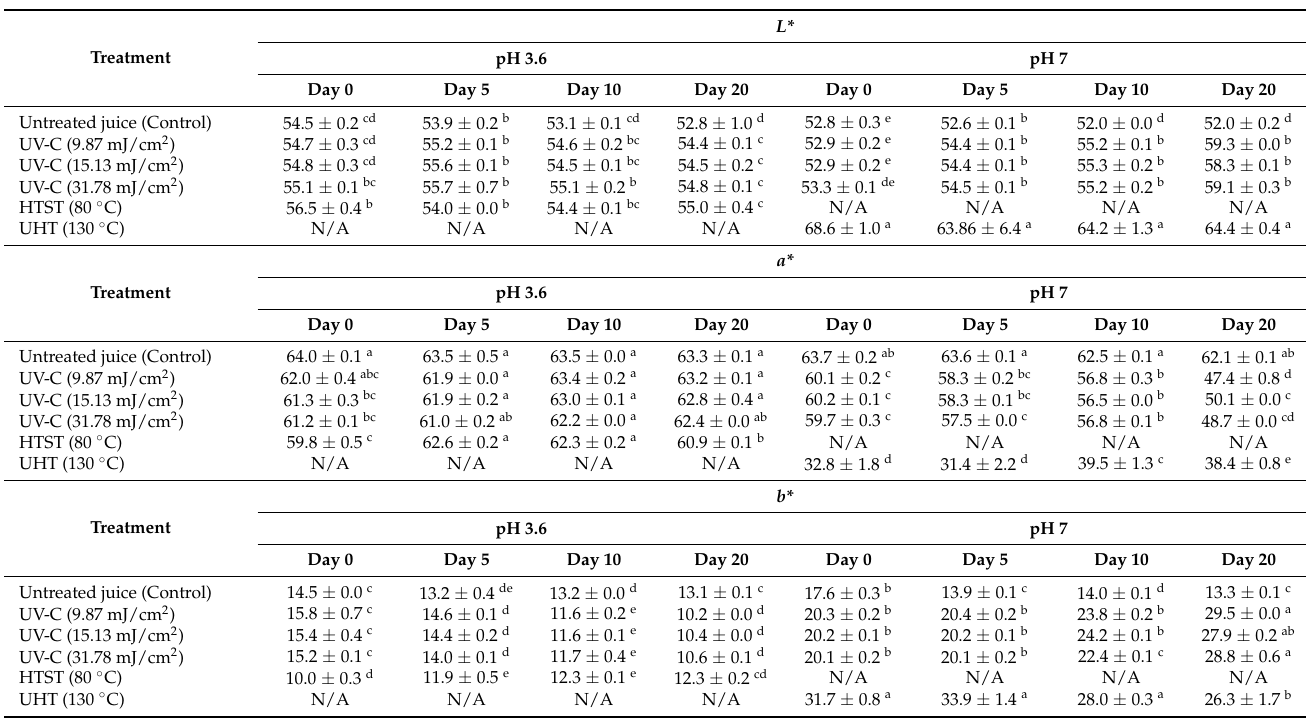
Table 4. Effect of UV-C irradiation and thermal treatment on color parameters ( L* , a* and b* ) of red prickly pear juice.